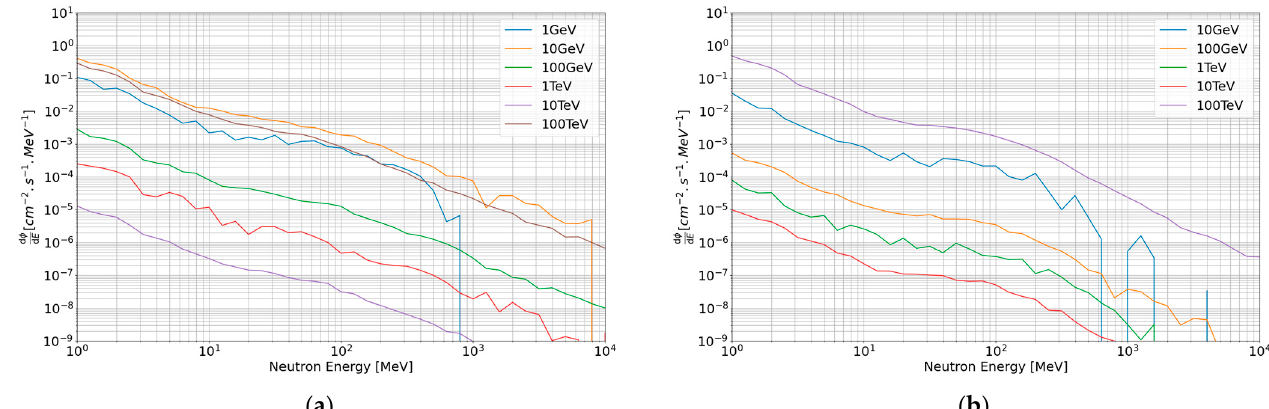
Figure 11. Spectrum of secondary neutrons according to the energy of the incident proton generated by each part of the primary particles spectrum given in Figure 8 at two altitudes: ( a ) at 18 km and ( b ) at 7 km.